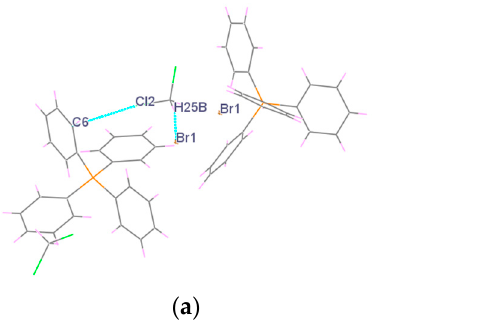
2 Cl 2 ); ( b ) TPPB (2H 2